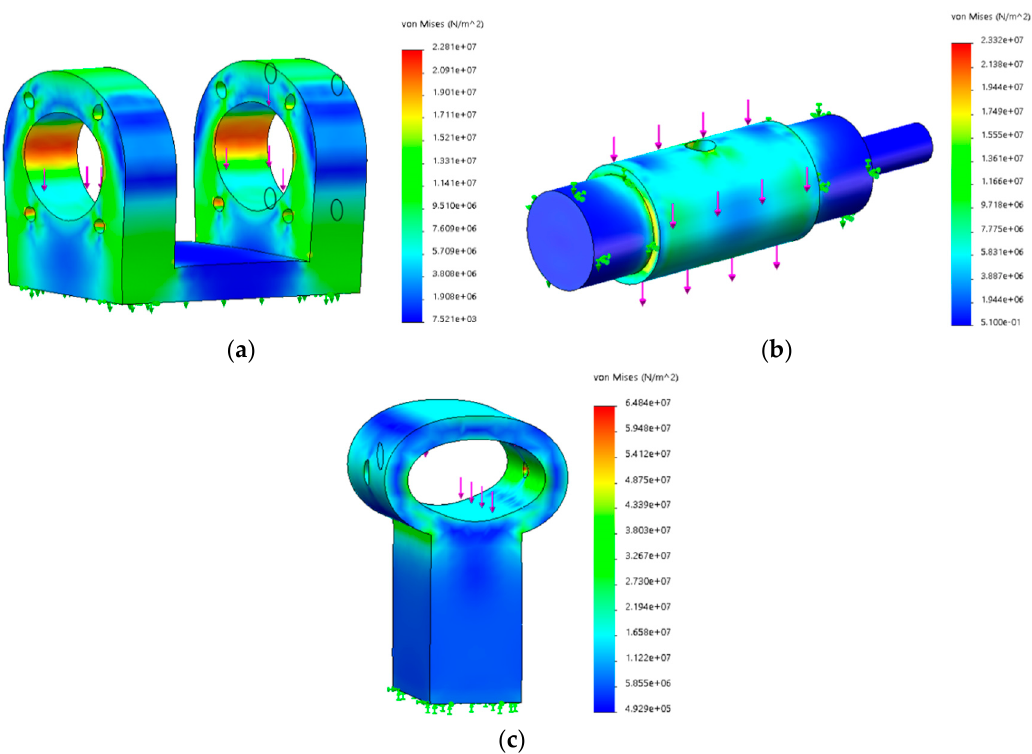
Figure 6. Finite element analysis of critical components. ( a ) U-shaped bracket. ( b ) Joint axis. ( c ) Joint sleeve.